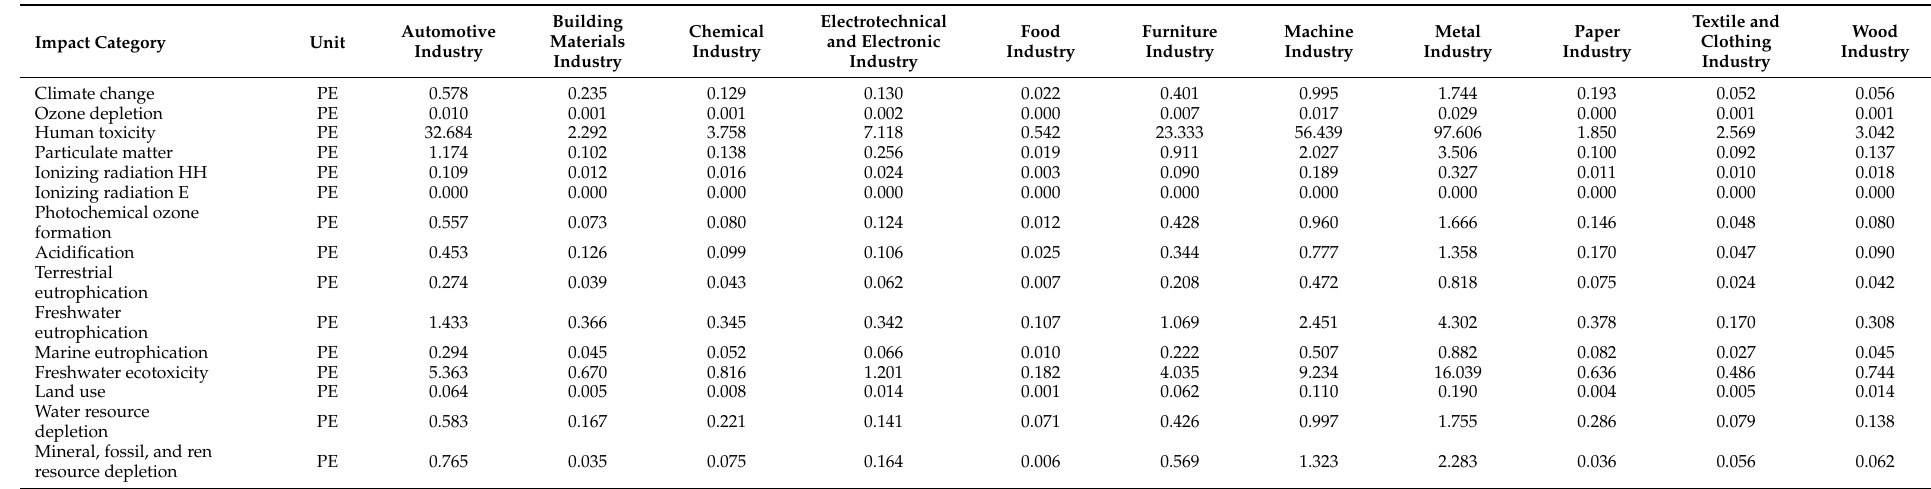
Table A3. Normalized environmental profiles of manufacturing in